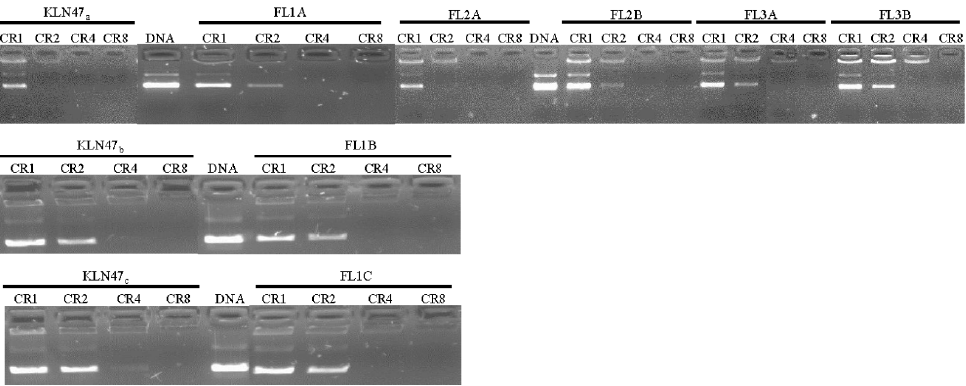
Figure 2. DNA binding ability of fluorescent compounds was evaluated in OptiMEM by mixing a constant mass of DNA (1 µ g) with different concentrations of cationic lipids corresponding to different CRs. DNA full complexation was highlighted by the absence of DNA migration into the agarose gel, at a given CR depending on the formulations tested.